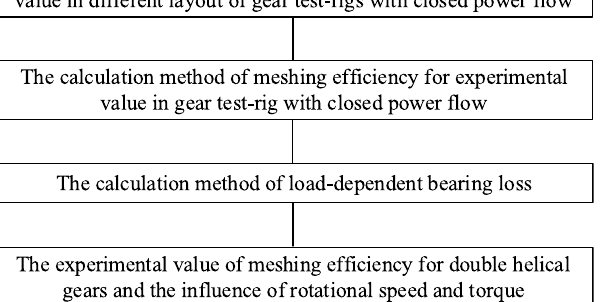
Fig. 2. The fl ow diagram for the calculation of experimental value of meshing ef fi ciency for double helical gears and the in fl uence of rotational speed